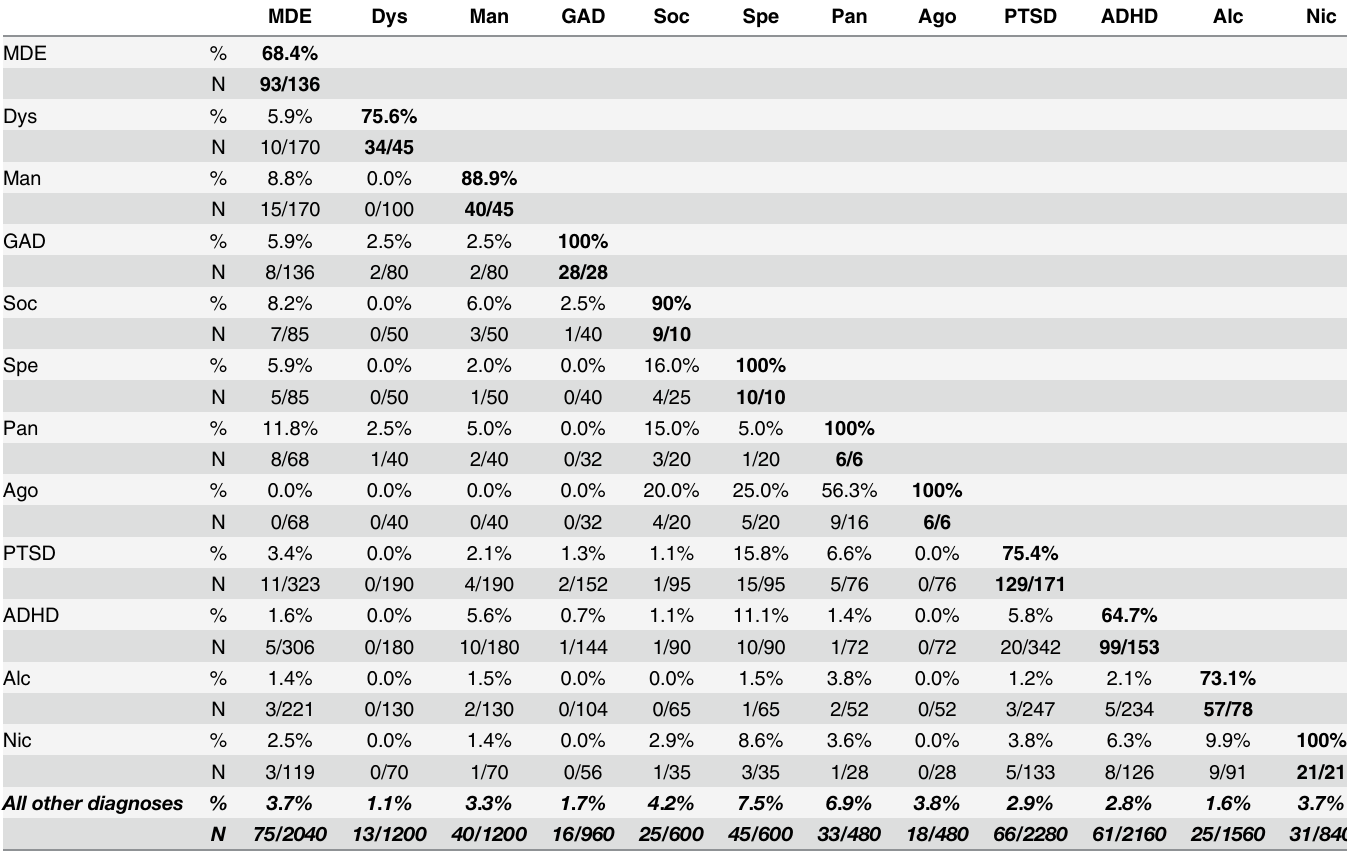
Table 1. Overview of the number of connections within and between